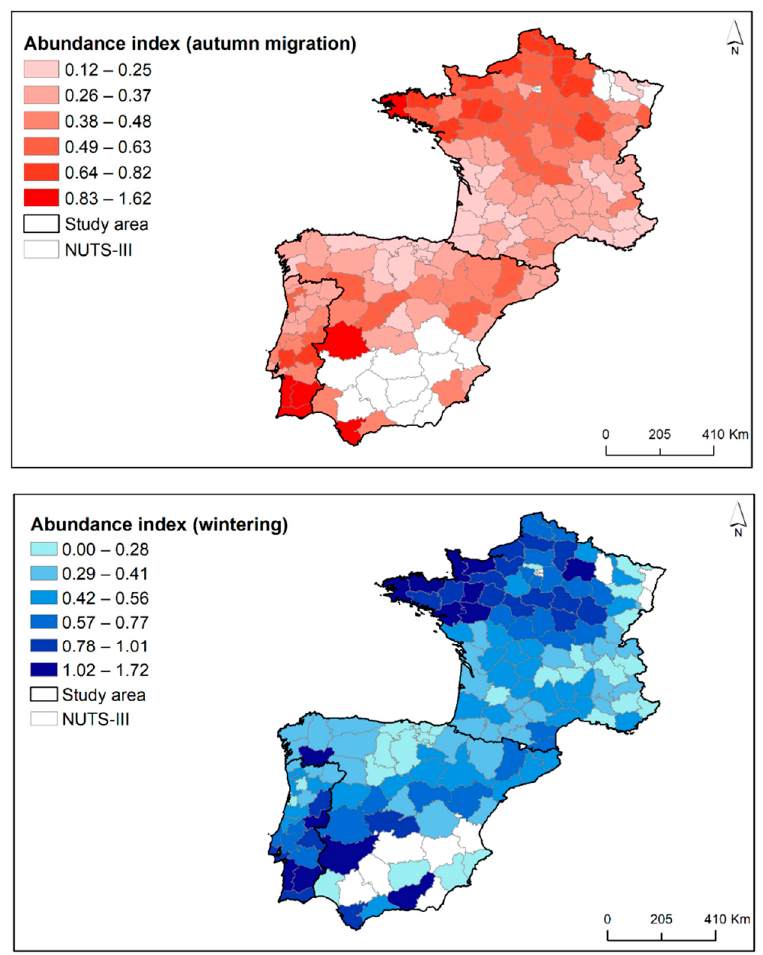
Figure 4. Spatial variation in the relative abundance index (for each NUTS-III the average value for each week was estimated and, subsequently, the average value for the set of weeks for each period), considering the aggregate set of hunting seasons (2009/2010 to 2017/2018). Representation with 6 classes, resulting from the application of Jenks’ algorithm [85]. NUTS-III white color—no data.